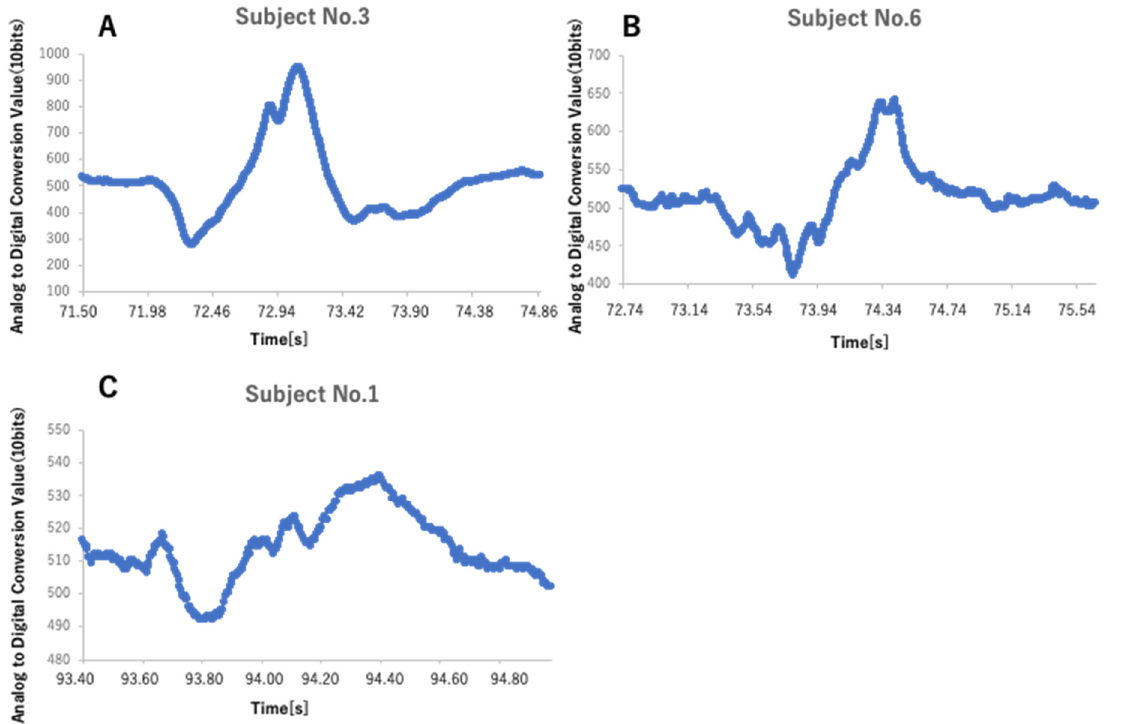
Figure 7. Example of waveforms for each subject. ( A ) Waveform of Subject No. 3, which is simpler and smoother than those of No. 6 and 7. Subject No. 3 had fewer errors than the other subjects on all items from DA to DC. ( B ) Waveform of Subject No. 6. It shows small tremors, suggesting the possibility that the carotid pulse was also captured by the recording. ( C ) Waveform of Subject No. 1, which also shows small tremors as in B. However, it is possible that the subject was only aware of swallowing for a short time, which caused the waveform to be stretched horizontally, thus clarifying the position of the plot. DA: Difference in the time of emergence of VA and SA; DC: Difference in the time of emergence of VC between SC.